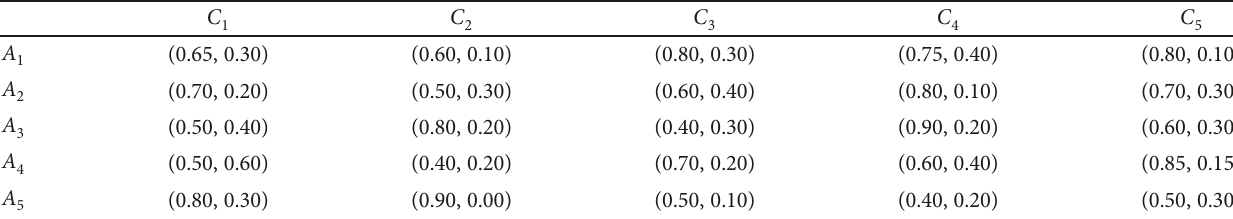
Table 1: Pythagorean fuzzy decision matrix D 1 .